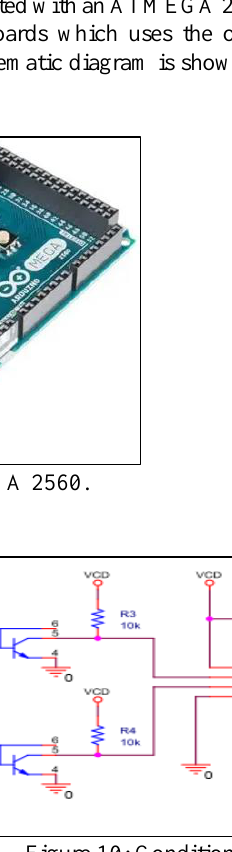
Figure 10: Conditioning circuit for trigger